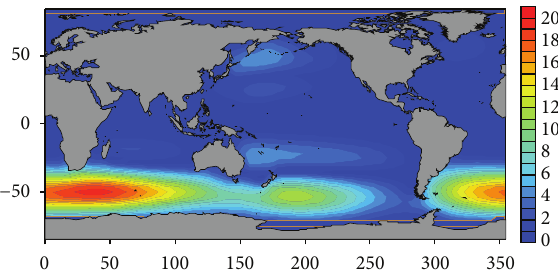
Figure 9: The spatial distribution of RMSE of sea surface tempera- ture for the biased